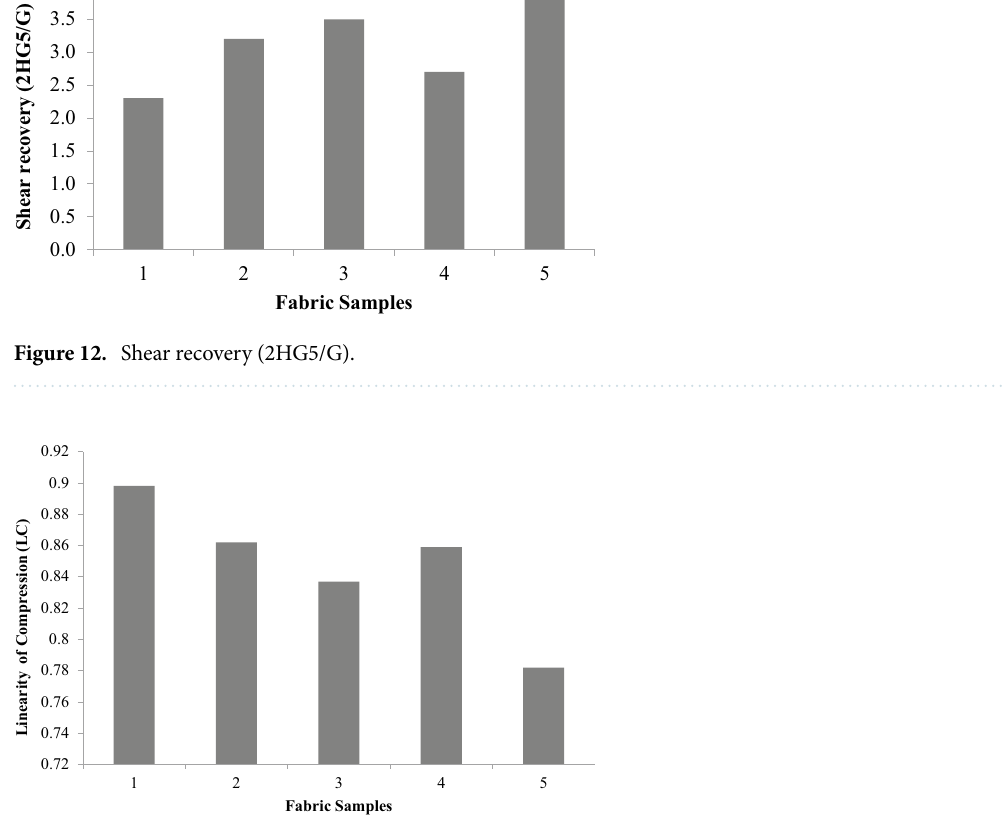
Figure 13. Linearity of compression (LC) of